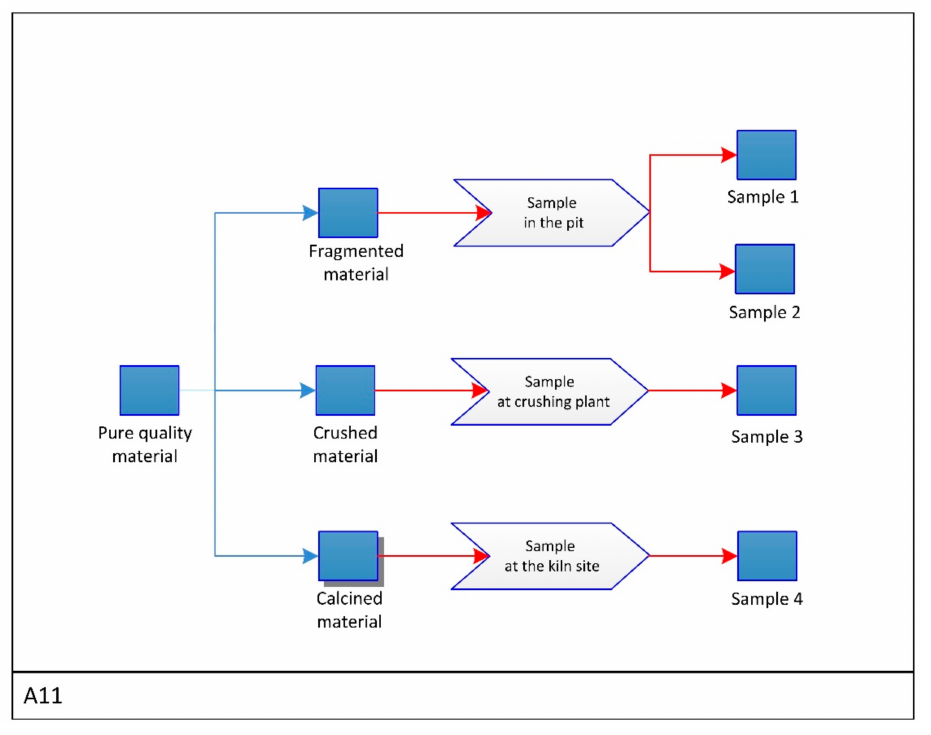
Figure 6. A case-specific geometallurgical flowsheet: A child diagram of the Sample